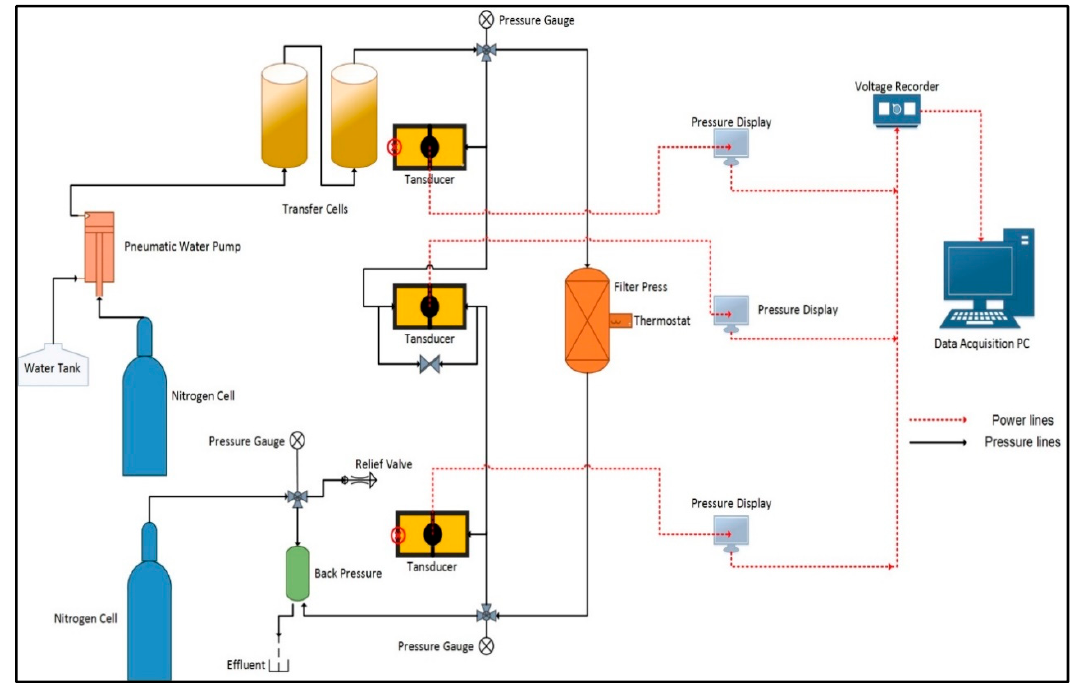
Figure 1. Filter-Press with continuous pumping set-up.